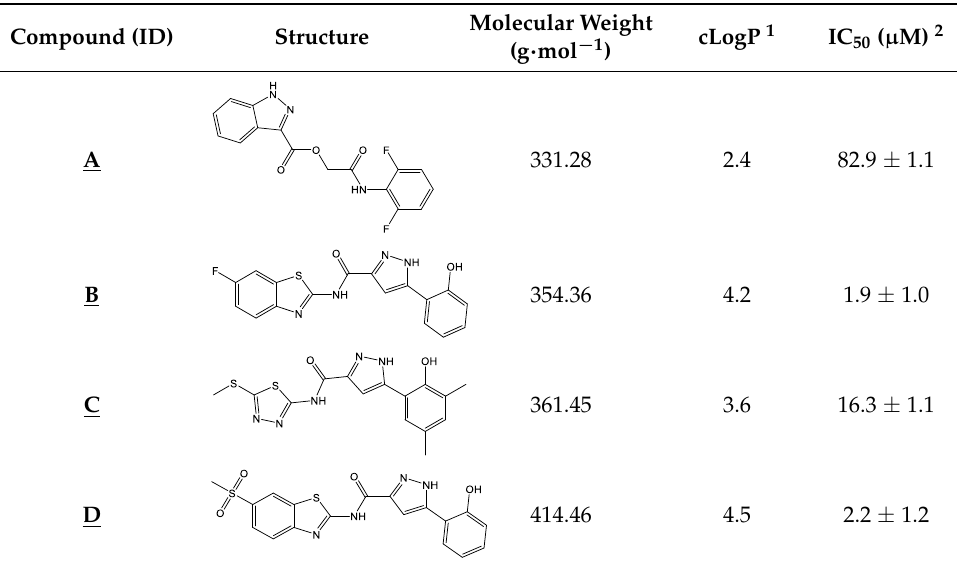
1 Values calculated with LigandScout 4.1 [51], using the topological cLogP estimation algorithm of Wildman and Crippen [55]. 2 Values obtained from a four-parameter logistic nonlinear model used to fit the experimental data from dose-response curves (Figure 2). All experiments were performed in a reaction mixture containing HEPES buffer (10 mM; pH = 7.4), MgCl 2 (2 mM), CaCl 2 (1 mM), human ecto -5 ′ -NT (3.6 nM), AMP (500 µM) as substrate and each tested compound over a range of concentration values (0 – 500 µM for A and 0 – 100 µM for B , C and D ). The concentration of DMSO in all samples was kept at 1.0% ( v / v ). Inorganic phosphate released in the reaction was quantified spectrophotometrically (at λ = 630 nm), using the malachite green method, as described in the literature [56].